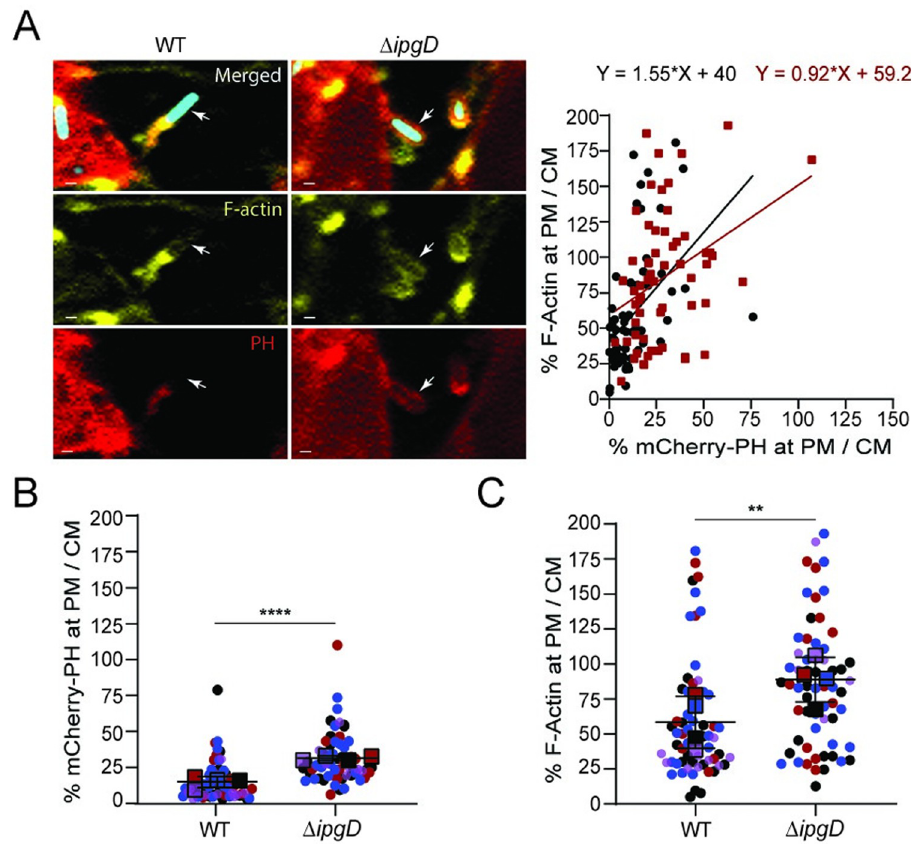
(CM) (quantification described in S6 Fig); 62 WT pCFP protrusions, 61 Δ ipgD pCFP protrusions; black circles, WT pCFP protrusions; red squares, Δ ipgD pCFP protrusions. Statistics: significance of mCherry-PH and F-actin relationship is determined by the difference of slope from zero. �� P < 0.01 based on a linear regression analysis explaining F-actin by mCherry-PH, strain, and an interaction between mCherry-PH and strain (R 2 = 0.22, F 3,119 = 13.02, P < 0.0001). Slopes of WT pCFP and Δ ipgD pCFP are not statistically different (P = 0.198). (B) Graph showing mCherry-PH levels at protrusion membrane (PM) normalized with mCherry-PH levels at cell membrane (CM); (quantification described in S6 Fig). (C) Graph showing F-actin at protrusion membrane (PM) normalized with F- actin levels at cell membrane (CM); (quantification described in S6 Fig). (B-C) Circles represent data points and colors indicate independent biological replicate groups; means (squares) of measurement from four biological replicates with s.d.; 62 WT pCFP protrusions and 61 Δ ipgD pCFP protrusions; ( n = 4). Statistics: unpaired t-test, ���� P < 0.0001, �� P <